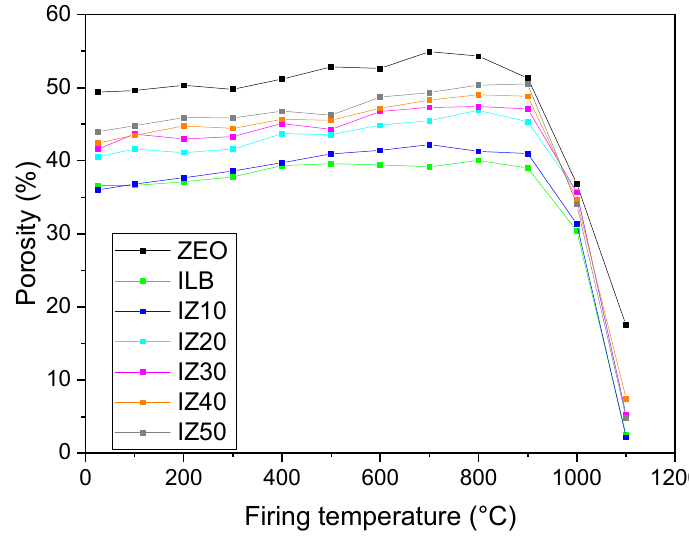
Figure 8. Porosity of the samples fired at different temperatures.